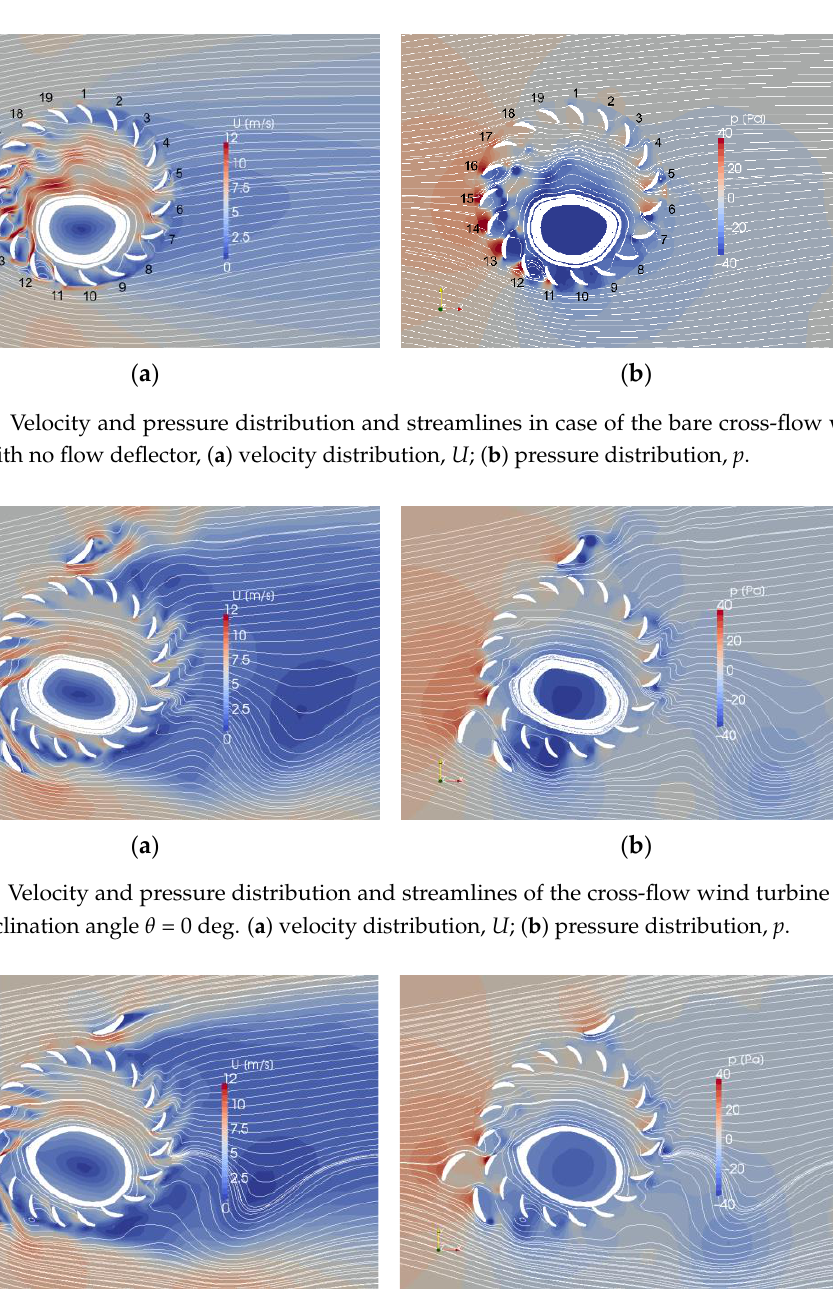
Figure 17. Velocity and pressure distribution and streamlines of the cross-flow wind turbine with TFD of inclination angle θ = −1 5 deg. ( a ) velocity distribution, U ; ( b ) pressure distribution, p .